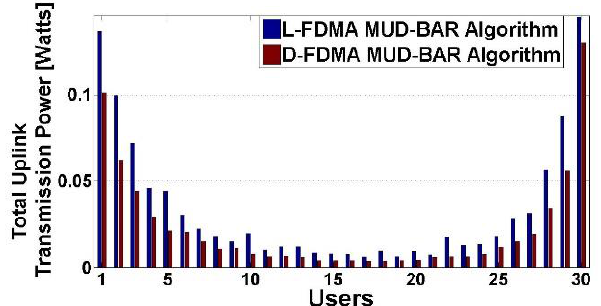
Fig. 10. Users’ uplink transmission power considering L- FDMA and D-FDMA subcarrier mapping method in MUD-BAR algorithm ( δ i+1 =δ i +0.007, δ 1 =0.75 ) . Two different scenarios are presented: a) L-FDMA: the users occupy sequential subcarriers and b) D-FDMA: the users occupy subcarriers in a distributed manner based on the maximum channel gain policy. Fig. 10 and Fig. 11 present users’ uplink transmission